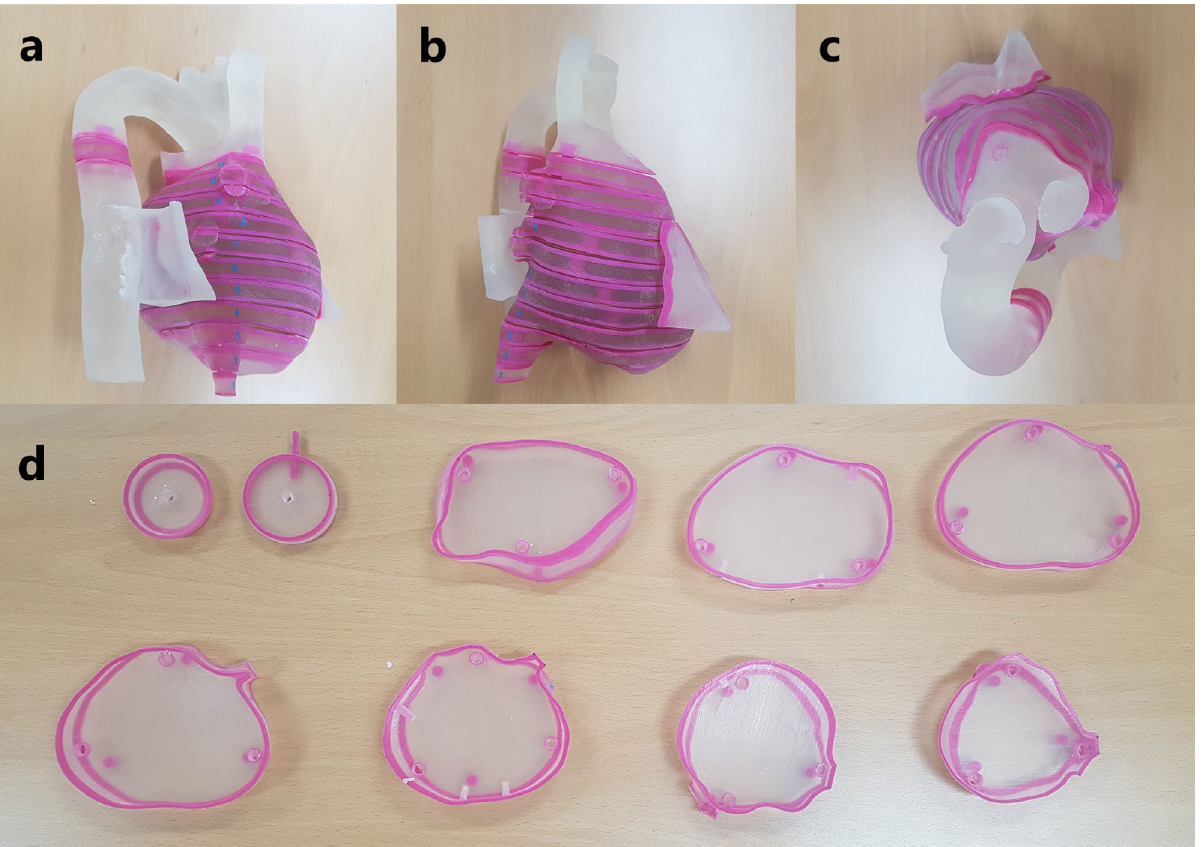
Figure 1. 3-D printed cardiac phantom set. ( a ) Lateral view, ( b ) anterior view, ( c ) top-down view, and ( d ) cardiac phantom